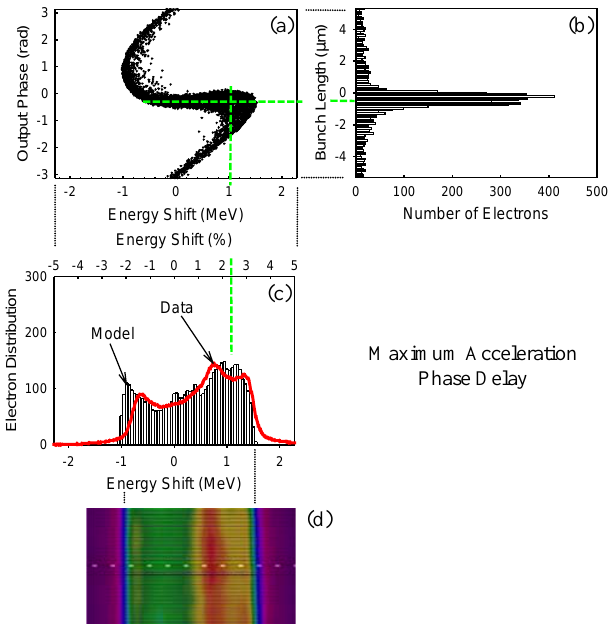
FIG. 3. (Color) Comparison of staging results with model for phase delay corresponding to maximum acceleration. (a) Model-predicted electron output phase versus electron energy, (b) model-predicted electron bunch length, (c) electron energy spectrum, and (d) raw spectrometer output for data plotted in (c).